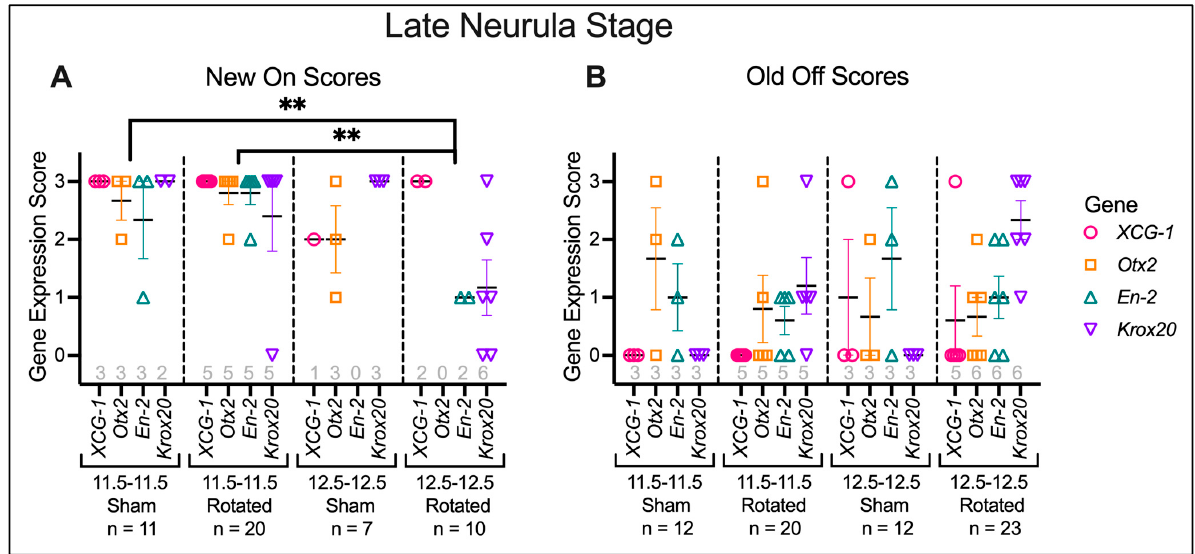
Figure 7. Histology scores for transplants at late neurula stage. Histological sections were scored for expression levels of regional marker genes, both correct “New On” expression ( A ) and ectopic “Old Off” expression ( B ). Horizontal black lines represent the mean, and error bars represent the SEM. ** p < 0.01. N for each gene and condition is indicated along the x-axis in gray. Late gastrula rotated embryos have significantly lower levels of correct marker gene expression than mid-gastrula sham embryos ( p = 0.0077) and mid-gastrula rotated embryos ( p = 0.0018).